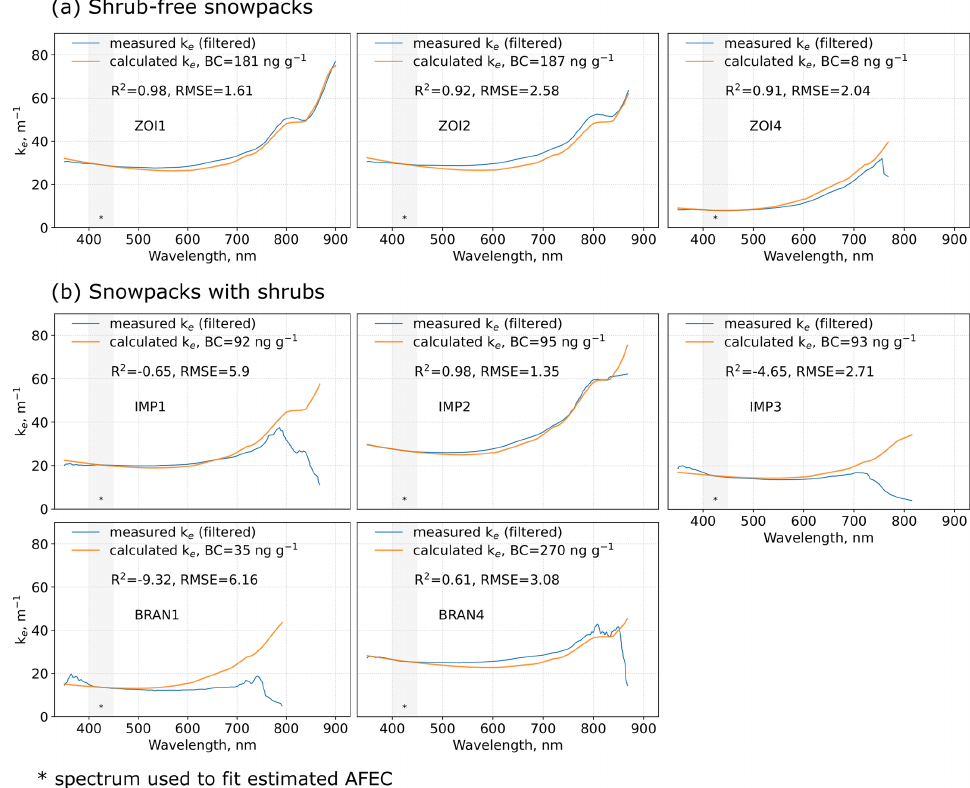
Figure 7. Measured and calculated k e for (a) ZOIs in shrub-free snowpacks and (b) IMP and BRAN layers identified in snowpacks with shrubs (see also Fig. 6). Grey areas highlight the spectral range where calculated k e was fitted to measured k e . Deviations at wavelengths > 680nm are interpreted as the influence of buried